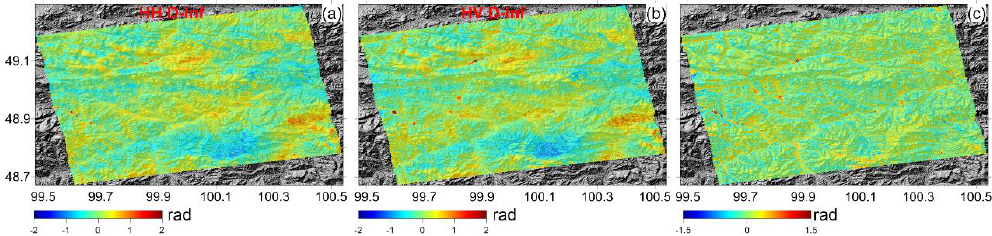
Figure 12. Original ( a ) HH and ( b ) HV D-Infs. ( c ) The difference map between the HV and HH D-Infs.